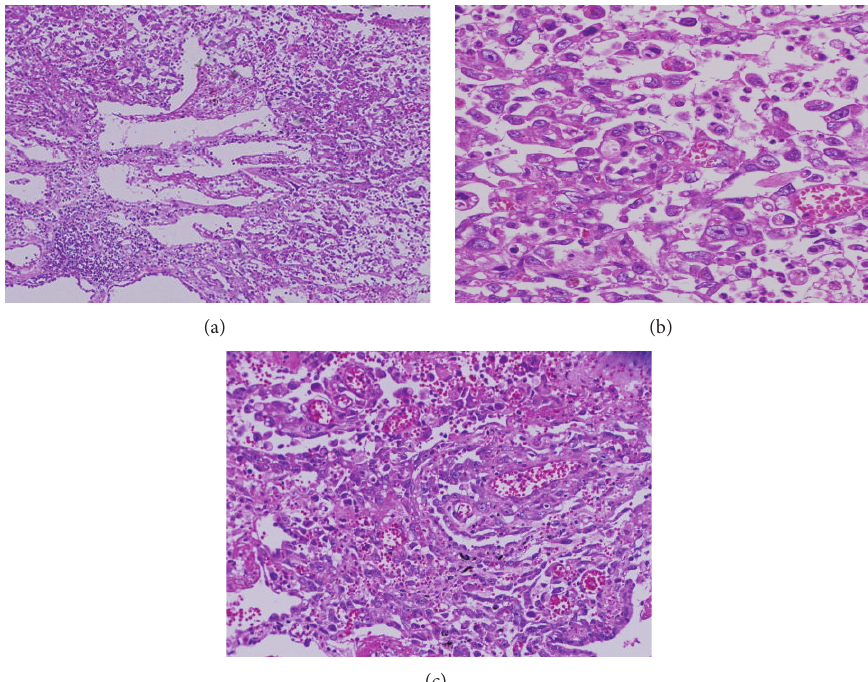
Figure 2: Microscopic findings of the tumor show mainly packed atypical pleomorphic spindle cells with giant cells ((a) hematoxylin and eosin stain, × 40; (b) × 400) and partial papillary adenocarcinoma ((c) × 100).